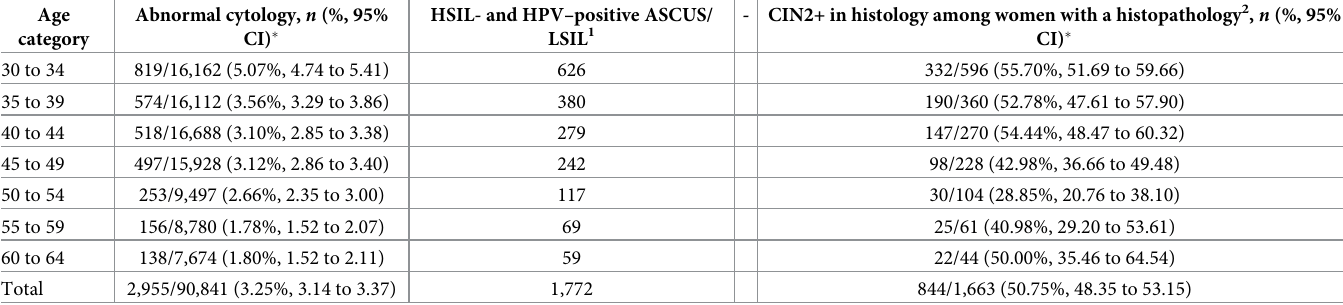
Table 4. Primary cytology policy screening and histopathology outcomes among 90,841 women who attended PP (organized screening). Age